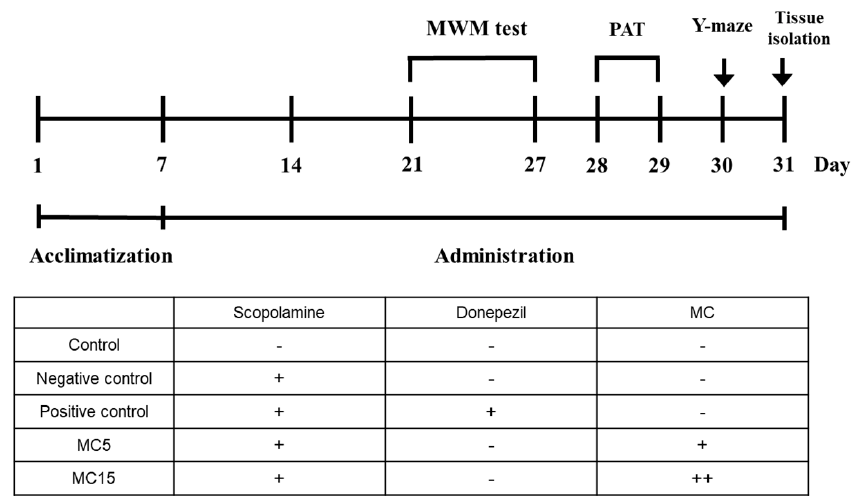
Figure 1. The schedule of animal behavioral experiments. MWM, Morris water maze; PAT, passive avoidance test. The injection volume used was 300 µ L. Scopolamine and donepezil were used at 5 mg/kg concentration. MC was used at 5 mg/kg (MC5) and 15 mg/kg (MC15). All solutions were made with PBS.